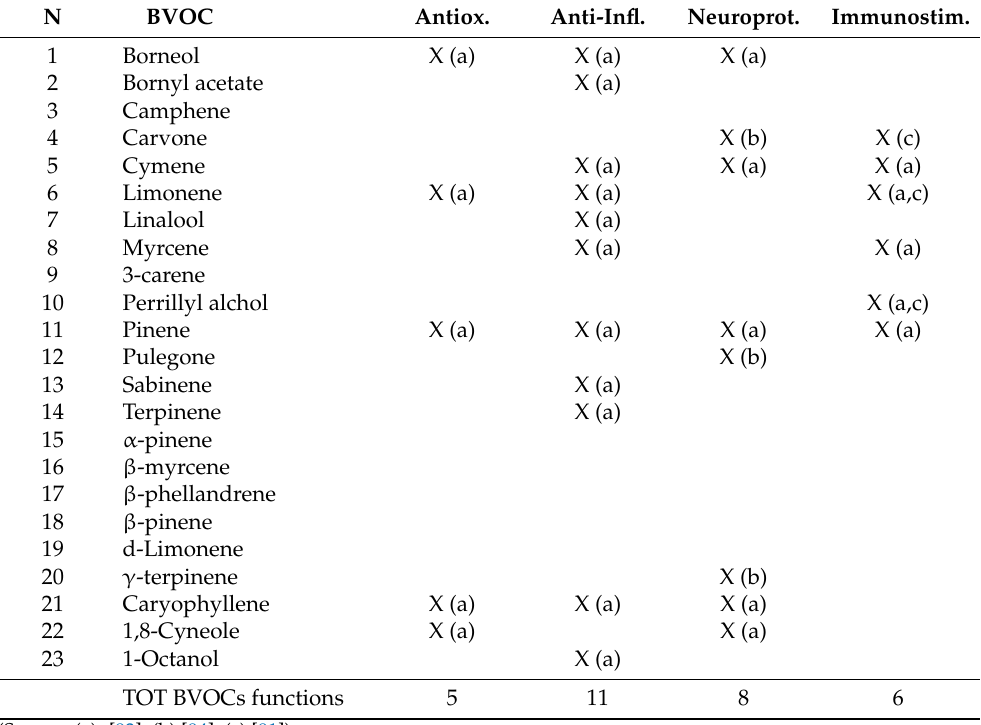
Table 3. Reported potential respiratory benefits of specific terpenes. BVOC Antiox. Anti-Infl.